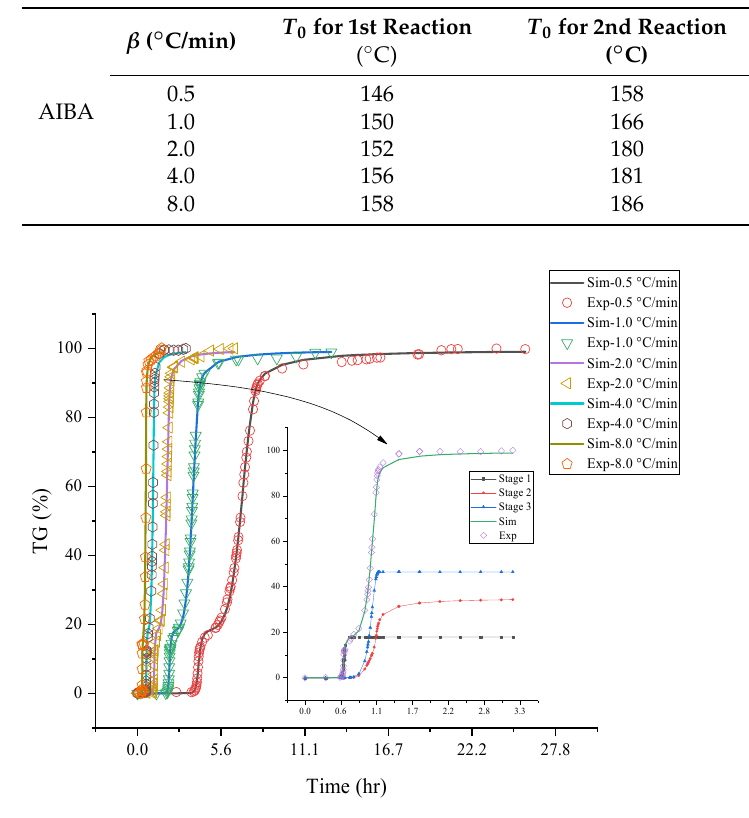
Figure 4. Mass loss of AIBA between TGA and nonlinear fitting results which contained multi-stage reactions by analyzing the experimental and simulated values of a single heating rate 4.0 °C/min along with other heating rates at 0.5, 1.0, 2.0, and 8.0 °C/min.